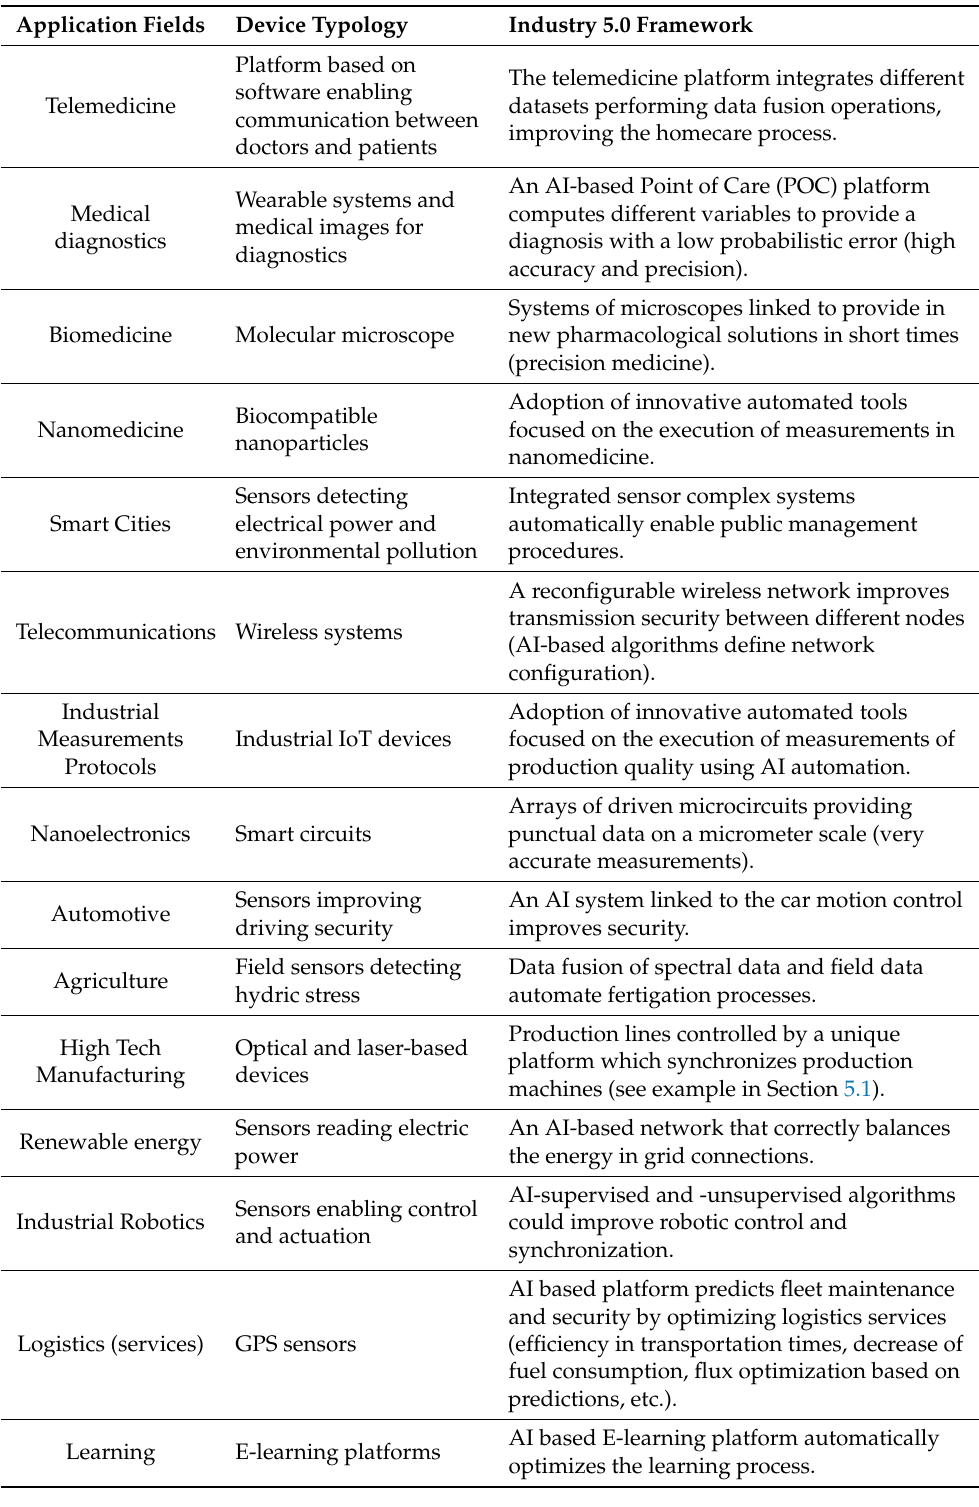
Table 8 indicates some examples of potential application fields and possible solutions for integrating the associated technologies into an Industry 5.0 scenario. Table 8. Examples of application fields matching with the Industry 5.0